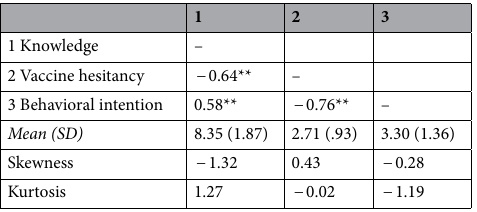
Table 4. Descriptive statistics of major variables in Study 2. ** p < 0.01.